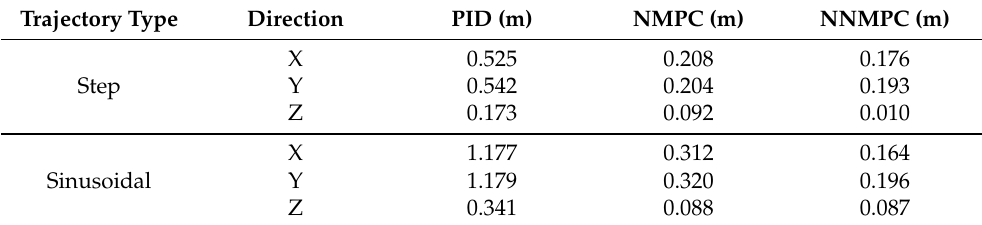
Table 3. RMSE of Trajectory Tracking from Simulation